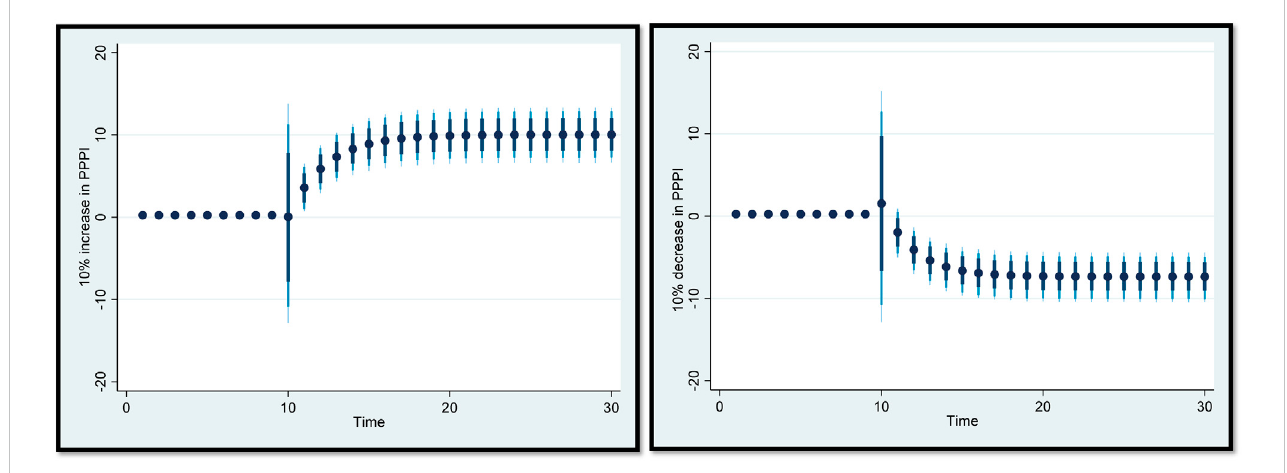
FIGURE 3 Impulse response plot for public – private partnership investment (PPPI) in energy and CO 2 emissions. An increase and a decrease of 10% in PPPI and its effect on CO 2 emissions, where dots denote the average prediction value. The dark blue to light blue lines show 75%, 90%, and 95% con fi dence intervals, respectively.